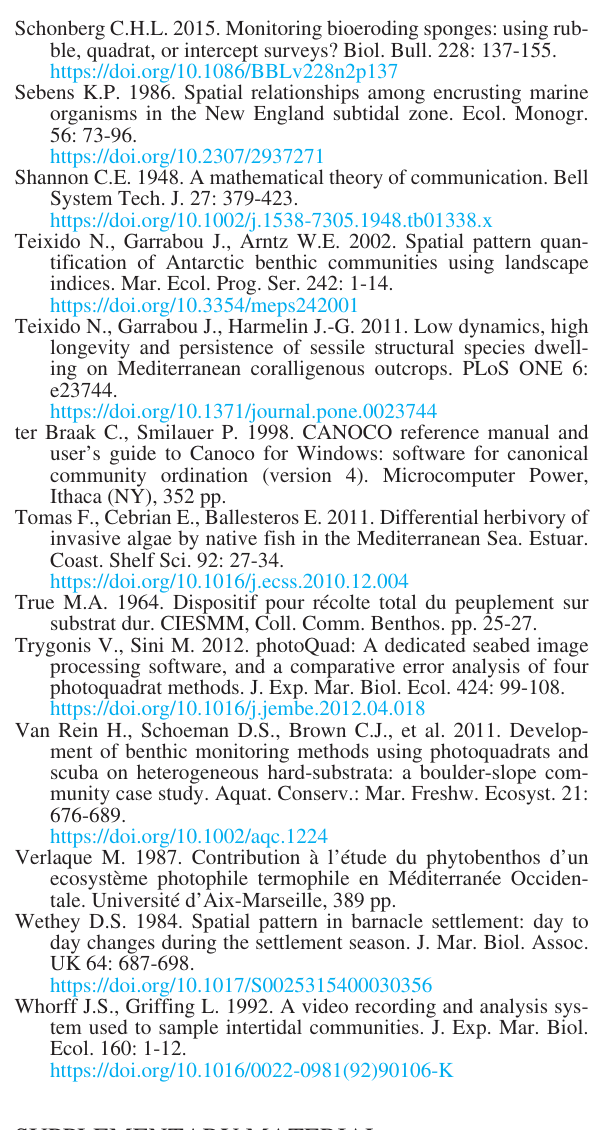
Table S1. – Species total biomass (g of dry weight) estimated with the collection method (2 replicates of 400 cm 2 ). Depth is ex- pressed in meters. Table S2. – Species abundance (%) estimated with the in situ visual Table S3. – Species cover (cm 2 ) estimated with the photoquadrat method (8 replicates of 310 cm 2 ). Depth is expressed in meters. Table S4. – Number of species (N) and species diversity (H’) for each depth, season and sampling method. CV is the seasonal coefficient of